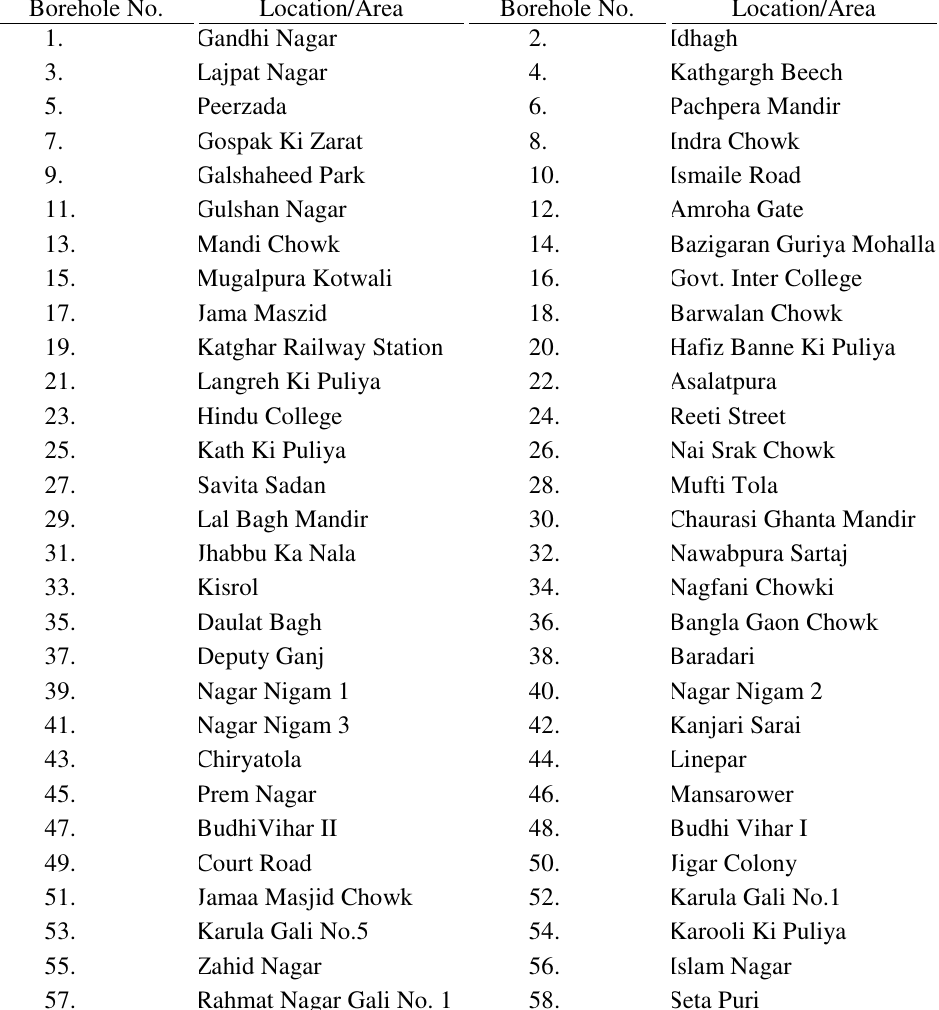
Table 1. Location of sampling stations (borehole location) Borehole